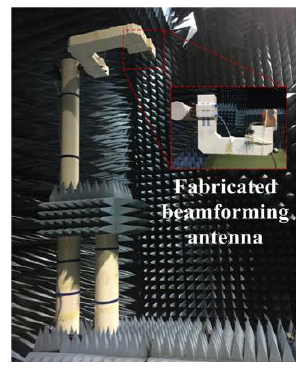
Figure 25. Measurement configuration of the fabricated beamforming antenna.